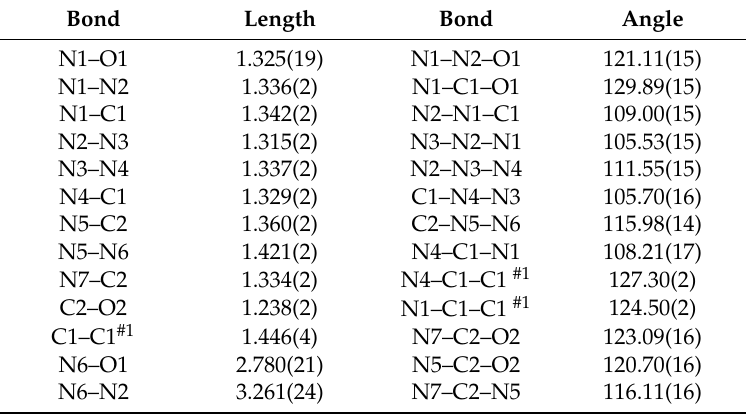
Figure 3. Packing diagram for salt 2(SCZ) ∙ BTO. Table 2. Selected bond lengths/Å and bond angles/° for salt 2(SCZ) ∙ BTO.